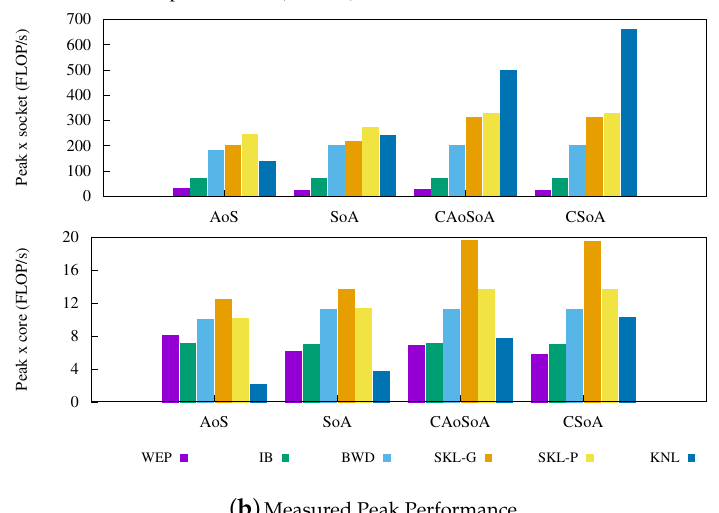
Figure 5. We report in ( a ) the measured memory bandwidth for the propagate kernel while in ( b ) the measured peak performance for the collide kernel. In this case, we compare several models representing 10 years of CPU manufacturing from the Intel product family, including the KNL many-core system. The performance measurement is reported using a single MPI process on the socket while scaling the number of threads up to the maximum number of core available on the given CPU socket, and it is performed on a lattice size of 256 3 representing a real